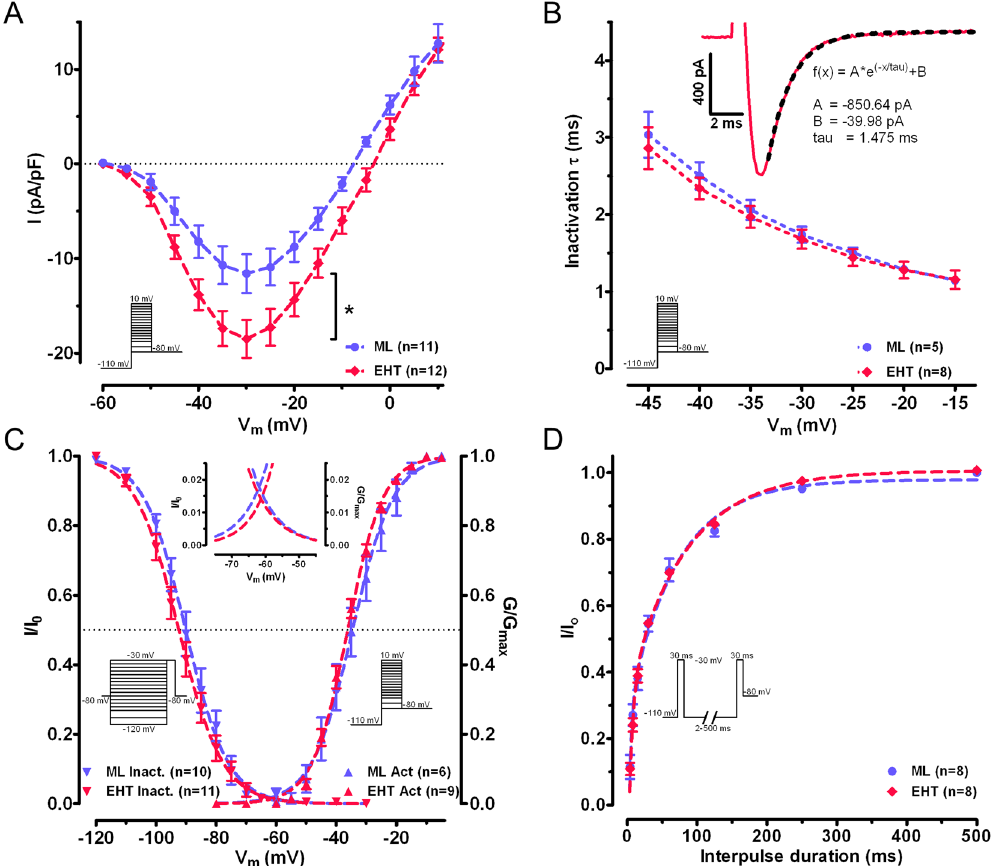
Figure 2. Biophysical properties of sodium current. (A) Current–voltage relationship in human induced pluripotent stem cell-derived cardiomyocytes: engineered heart tissue vs. monolayer, * p < 0.05. ( B ) Inactivation kinetics of I Na were fitted by a single exponential function and characterised by the time constant τ as a function of the depolarisation step. An exemplary original trace of I Na in EHT hiPSC-CM is shown (inset) with a function fitted as a dotted line and corresponding parameters. ( C ) Steady-state inactivation and activation relations for I Na . The dotted lines represent fitted data calculated by a Boltzmann function. Insets show curves at higher magnification to illustrate the overlap at ~62.5 mV and maximal window current of 1–2%. ( D ) Recovery from inactivation of I Na using a double-pulse protocol varying intervals (2 to 500 ms). Dotted line represents curve fits by a two-phase exponential